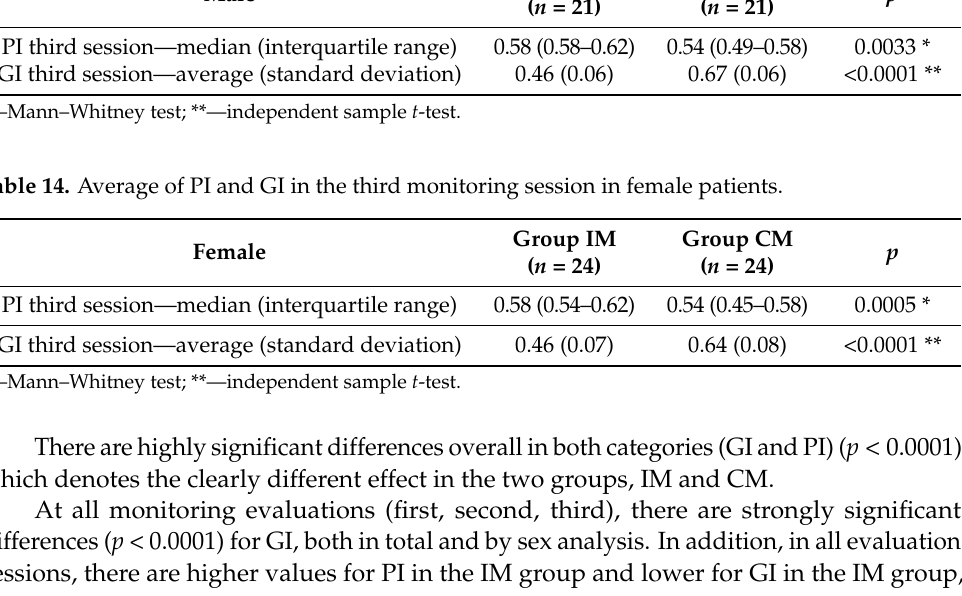
Group IM Group CM p ( n = 21) ( n = 21)